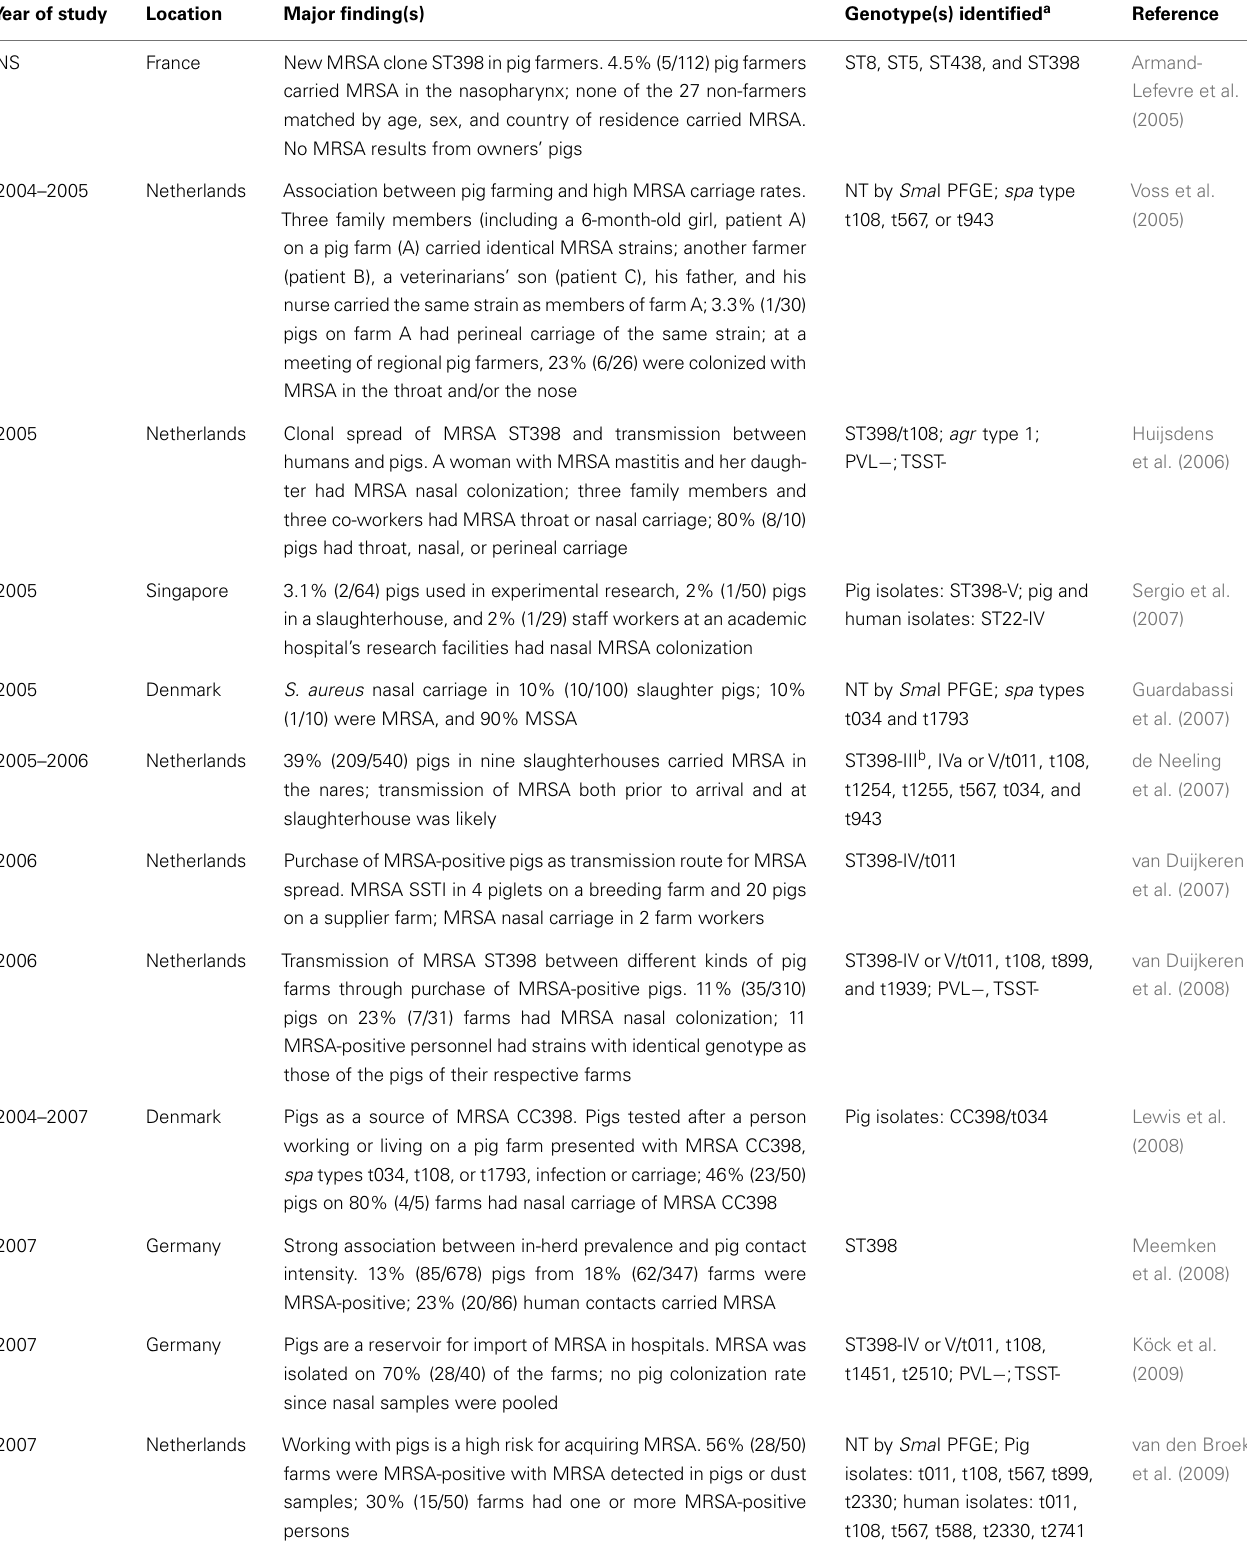
Table 1 | Summarized chronology of publications reporting MRSA carriage and infection in pigs and their human contacts,